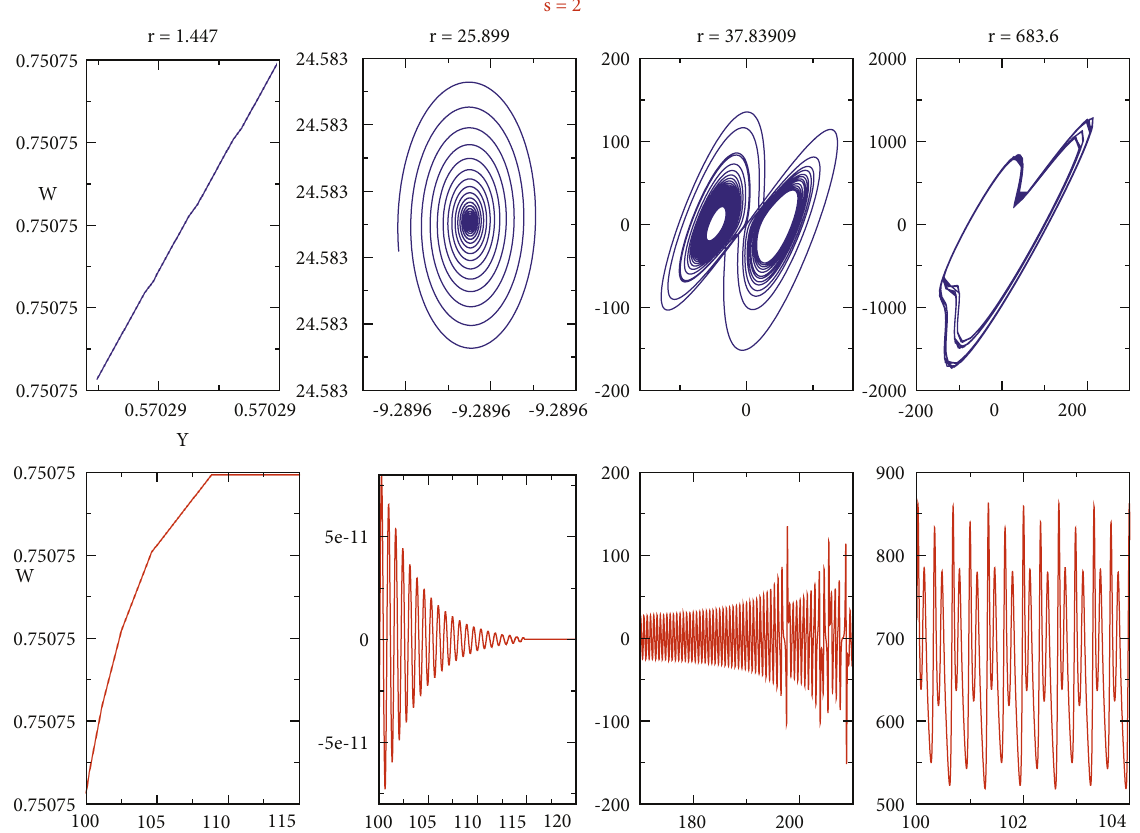
Figure 7: Phase portraits andtime stories for different valuesof the reduced number of Rayleigh r when s � 2 with theparameter values of Figure